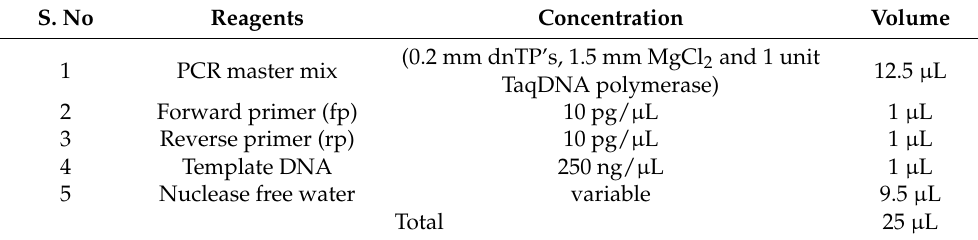
Table 2. Concentrations and volumes of reagents used in PCR.